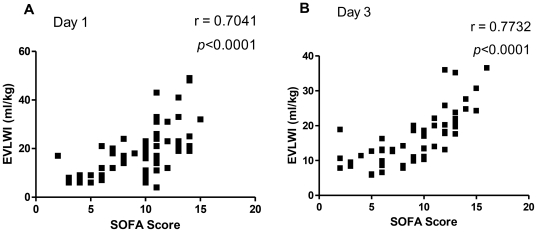
The relationship between extravascular lung water index levels (EVLWI) and SOFA score in patients with severe sepsis.The higher of SOFA score, the more EVLWI was found on day 1 (r = 0.7041, p<0.0001) and day 3 (r = 0.7732, p<0.0001). The data are expressed as Spearman test.